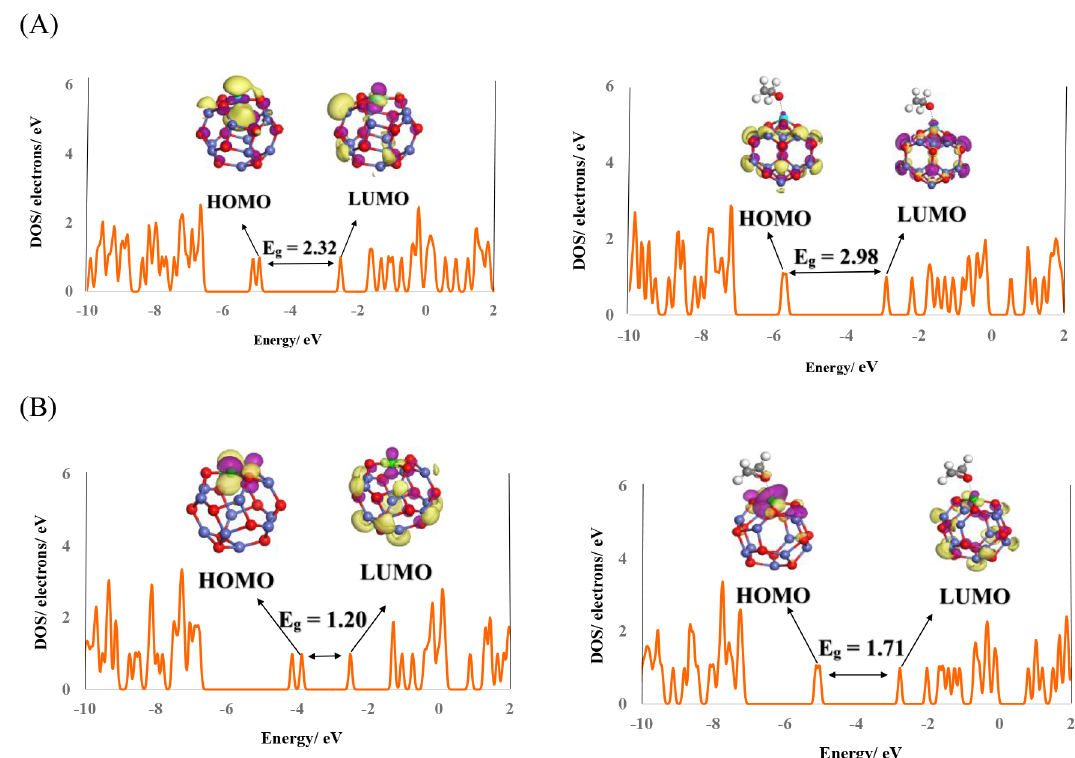
O and EO/V-doped Zn 12 12